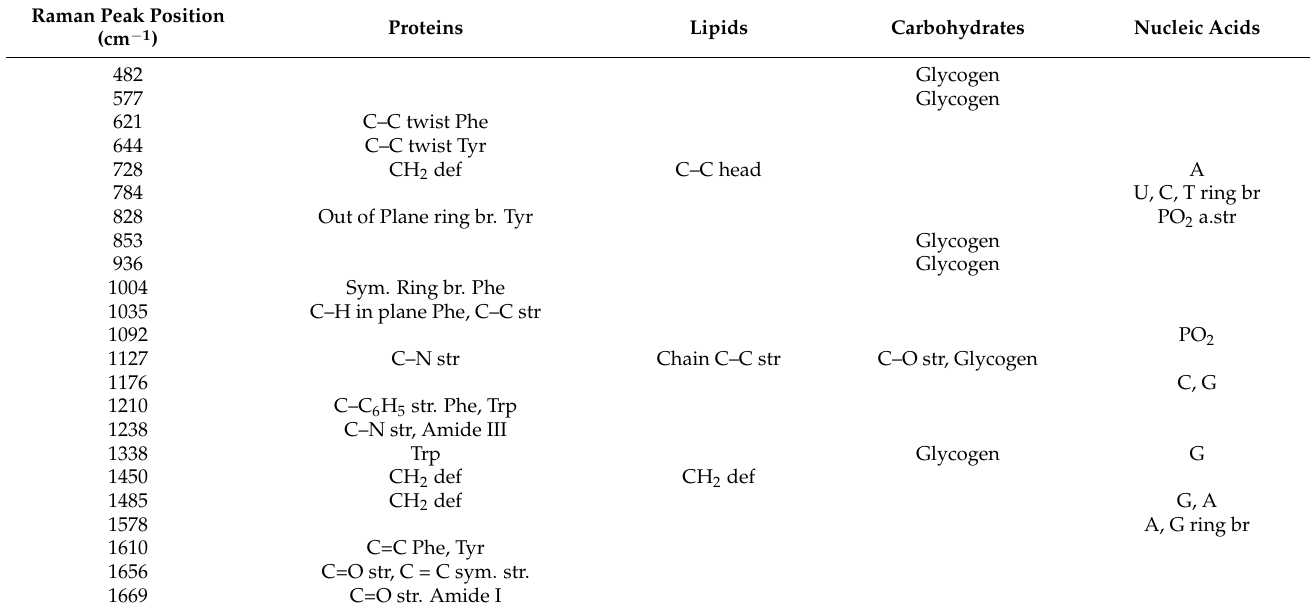
Table 2. Tentative peak assignments